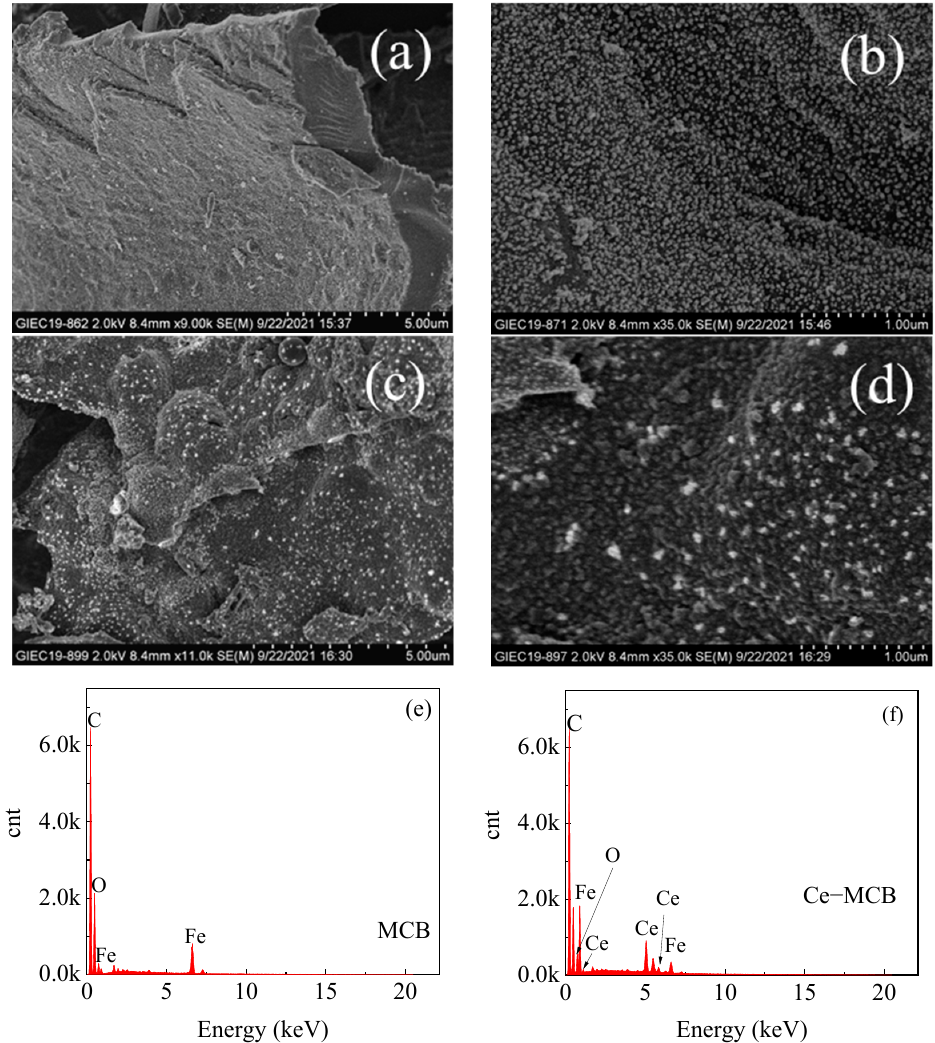
Figure 1. SEM image of MCB ( a , b ) and Ce-MCB ( c , d ), EDX spectra of MBC ( e ) and Ce-MCB ( f ).